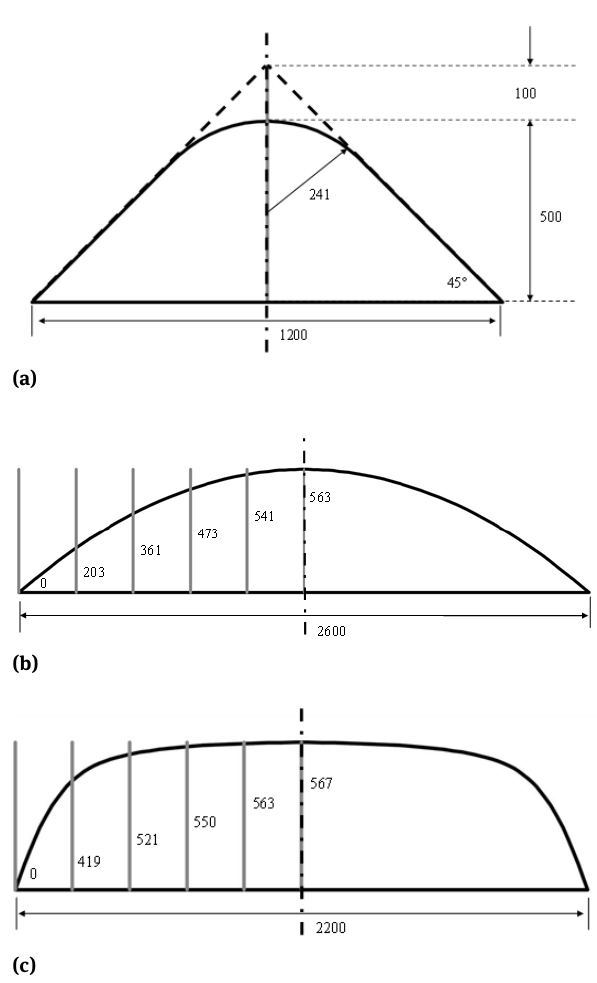
Figure 3: Selected obstruction geometries applied in grounding analysis: (a) conical rock in previous work [22], (b) polynomial rock and (c) idealised shoal. The unit is determined to be in mm.